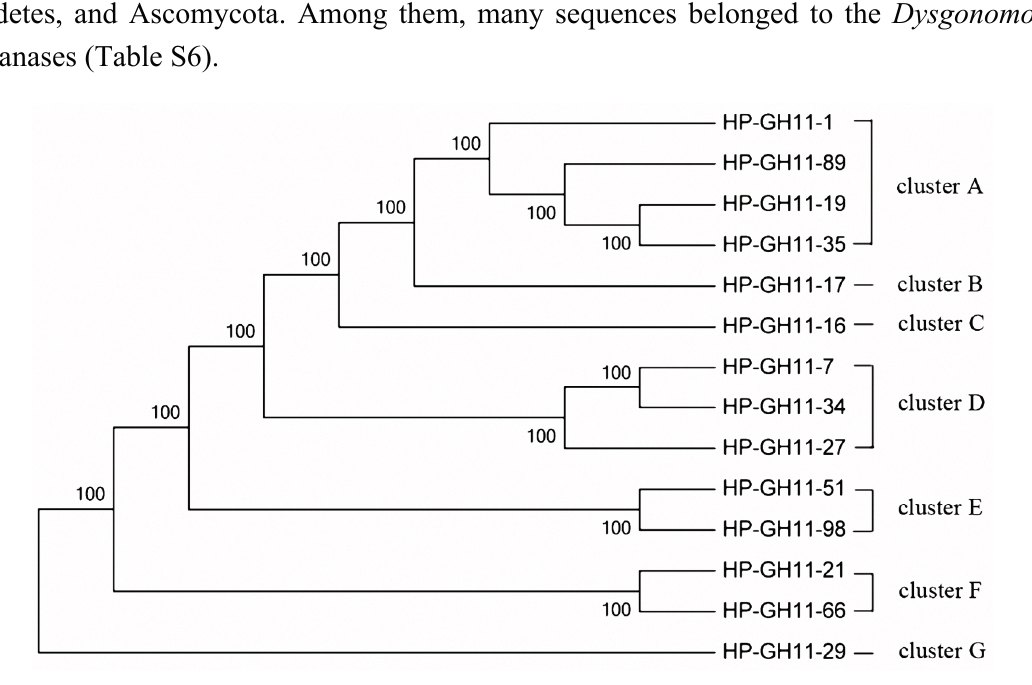
Figure 7. Maximum Likelihood phylogenetic tree of the GH11 amino acid